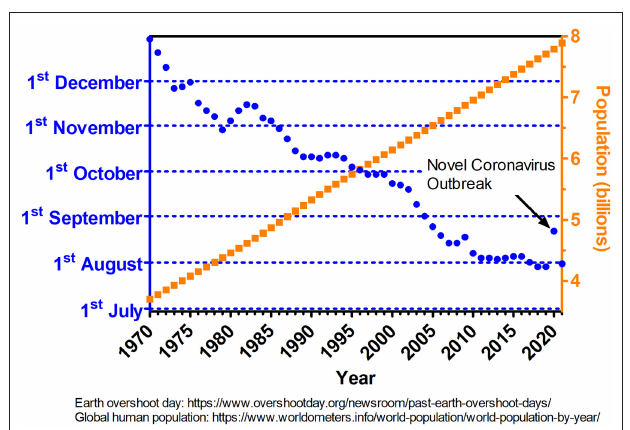
FIGURE 1 | Earth overshoot day (blue) and global population (orange) evolution over the last 50 years.